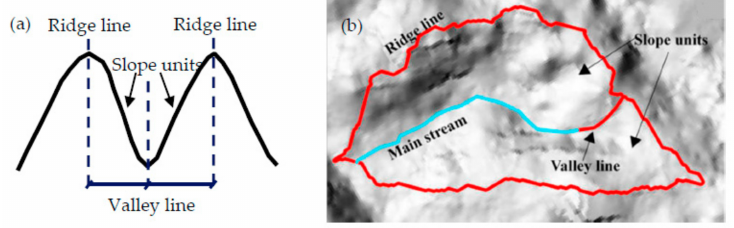
Figure 1. Division of two slope units in a catchment: ( a ) a slope unit sketched map; ( b ) a slope unit planar map.